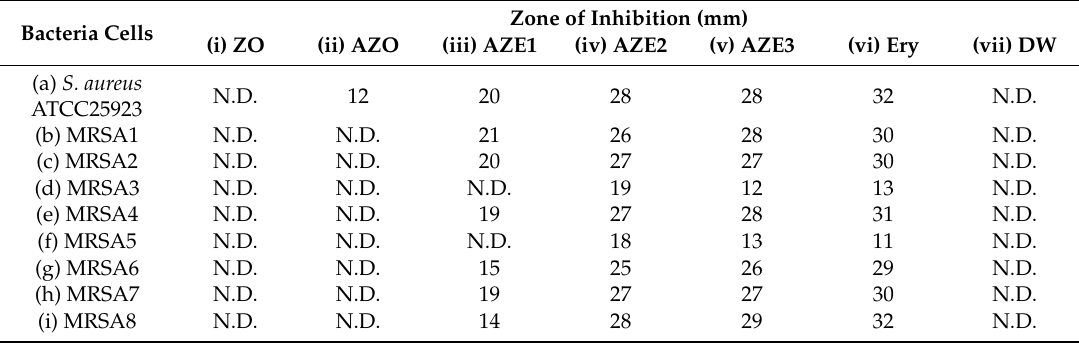
Table 2. Zone of inhibition (ZOI) diameter of ZO and AZE against (a) S. aureus and (b–i) MRSA1–8 was measured from n = 3 and representative data are shown.